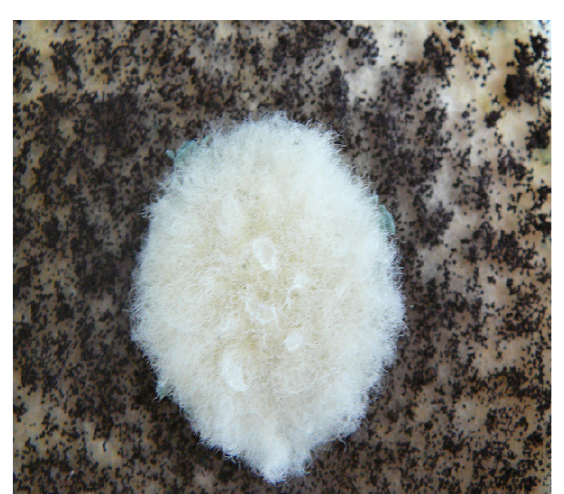
Figure 3. CD spectra of collagen contained into Col-PHU (3), Col- Cr-PHU-PP (5), Col-PHU-Cr-PP (18) and Col-PHU-PP-Cr (19).